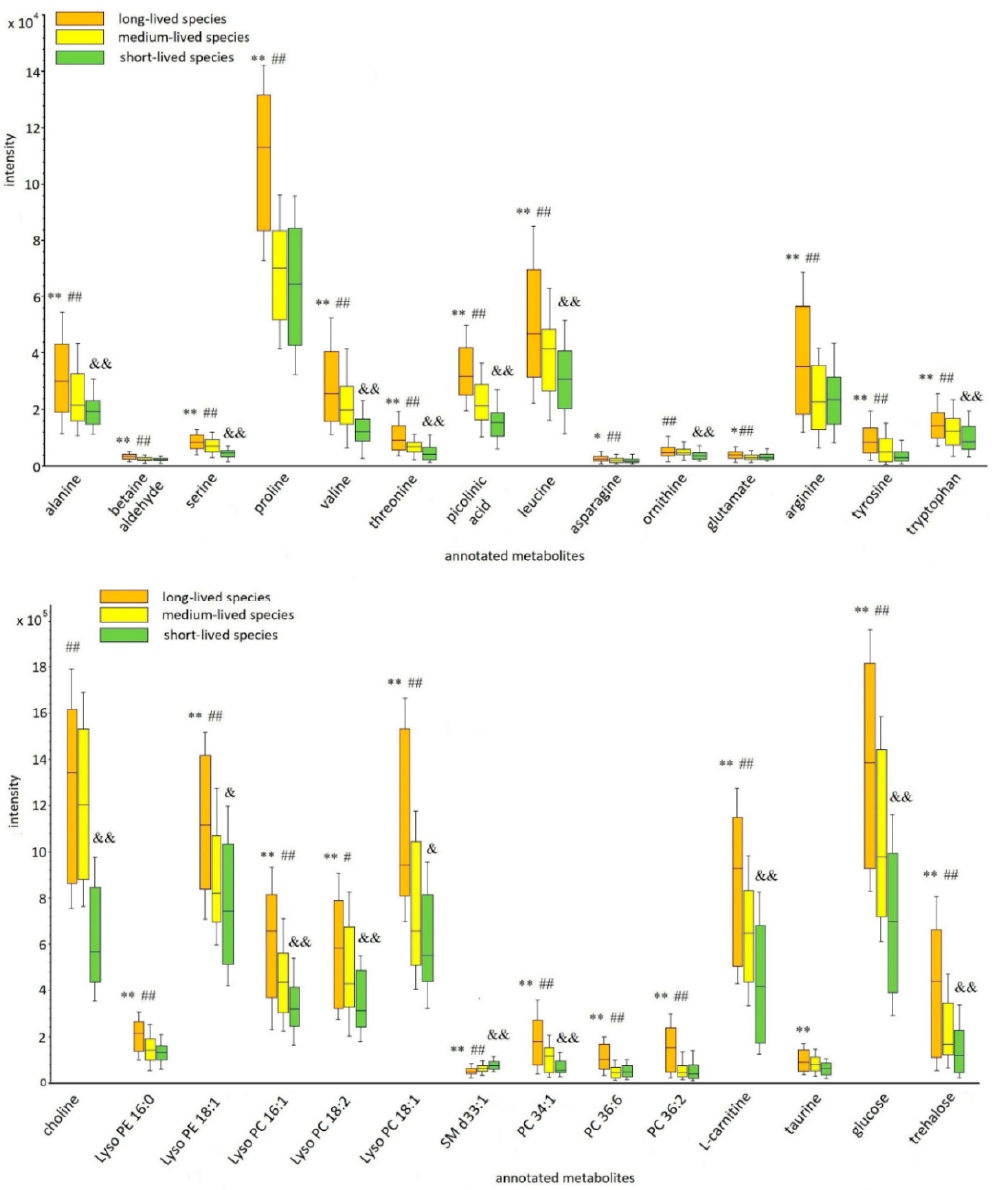
Figure 3. Box and whisker plots of the annotated metabolites between cohorts of Drosophila species. The box-whisker plot presents the distribution of normalized intensity values of the annotated metabolites. The top and bottom of the boxes represent the 25% and 75% percentiles; the 5% and 95% percentiles are indicated as error bars. The median value is indicated by horizontal lines within each box. The outliers were eliminated before the analysis. The results of the pairwise comparisons of the metabolite levels between cohorts are displayed (the changes were calculated using medians of individual metabolite levels across the lifespan). The pairwise differences were calculated by the Mann–Whitney U test (* p ≤ 0.05 (** p ≤ 0.01), significant change between long-lived and short-lived species; # p ≤ 0.05 ( ## p ≤ 0.01), significant change between long-lived and medium species; & p ≤ 0.05 ( && p ≤ 0.01), significant change between medium-lived and short-lived